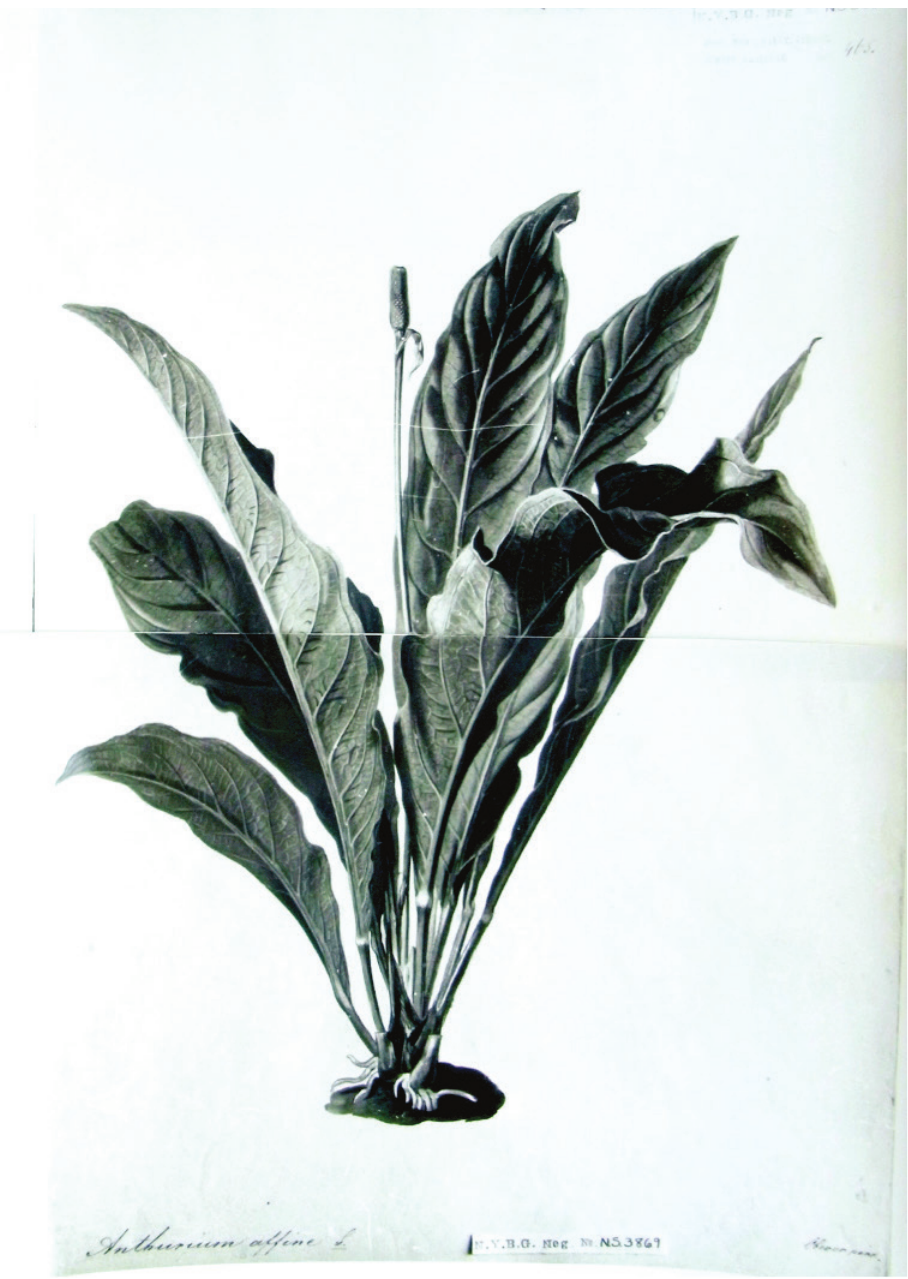
Figure 1. Neotype of Anthurium affine , the reproduction of the original coloured gouache Schott Icones Aroideae n o 465 , deposited in herbarium NYBG (NYBG Neg.